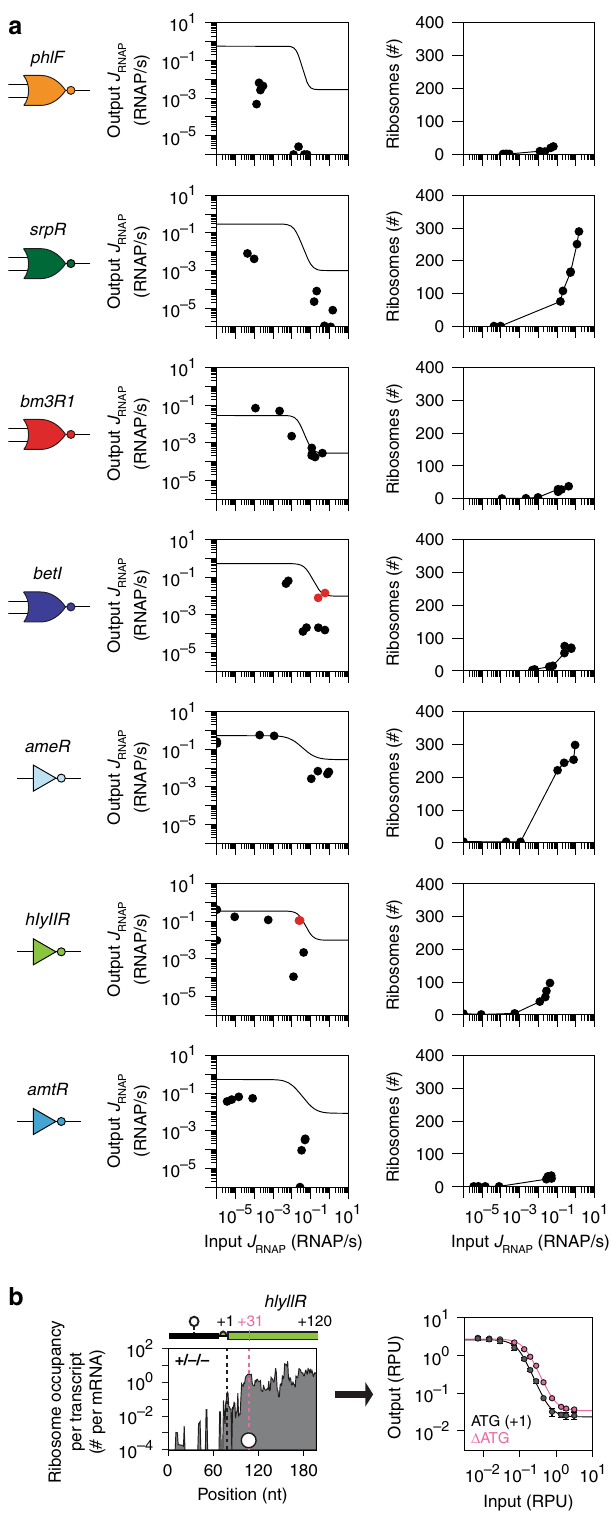
Fig. 4 Gate responses. a Data for each gate are shown. (left column) The line indicates the response function, measured when the gate is in isolation 14 (converted to RNAP/s, Methods). The data points correspond to the input and output J RNAP extracted from the RNA-seq data for all eight states. Red dots show states of BetI and HlyIIR gates that have failed. (right column) The number of ribosomes used by the gate as a function of the input promoter activity. b Translation from an alternative start codon for hlyIIR is shown. Black dashed line is the position of annotated start codon, and white circle (legend in Fig. 2a) and pink dashed line show the position of alternative start codon. The response functions of the original (ATG at + 1) and mutated (ATG at + 1 deleted) hlyIIR are compared. Data are the average ±standard deviations from three independent measurements on separate days. Source data are provided as a Source Data fi